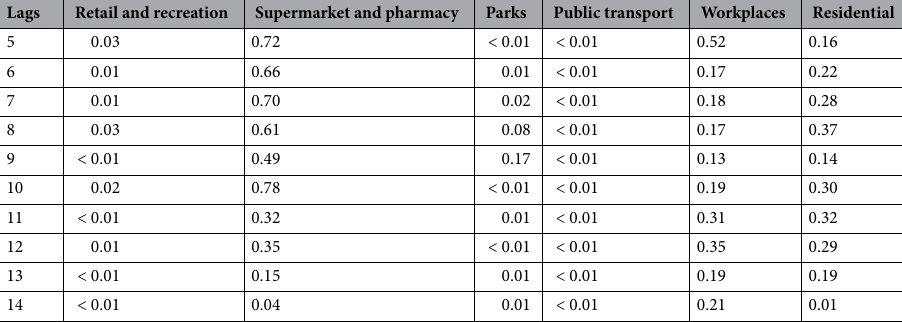
Table 6. Granger causality testing mobility variables predictive of 14-day CI for different lag orders.